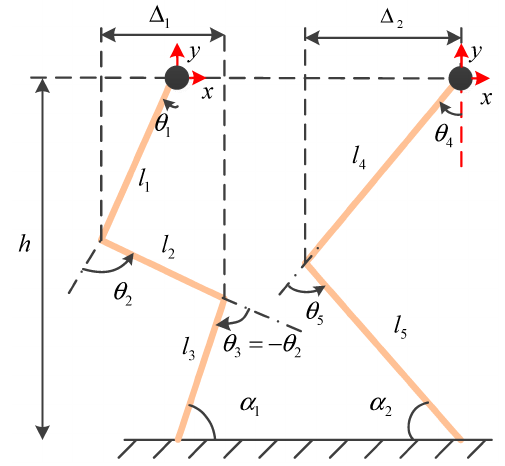
Fig. 3 The configuration parameters of the leg